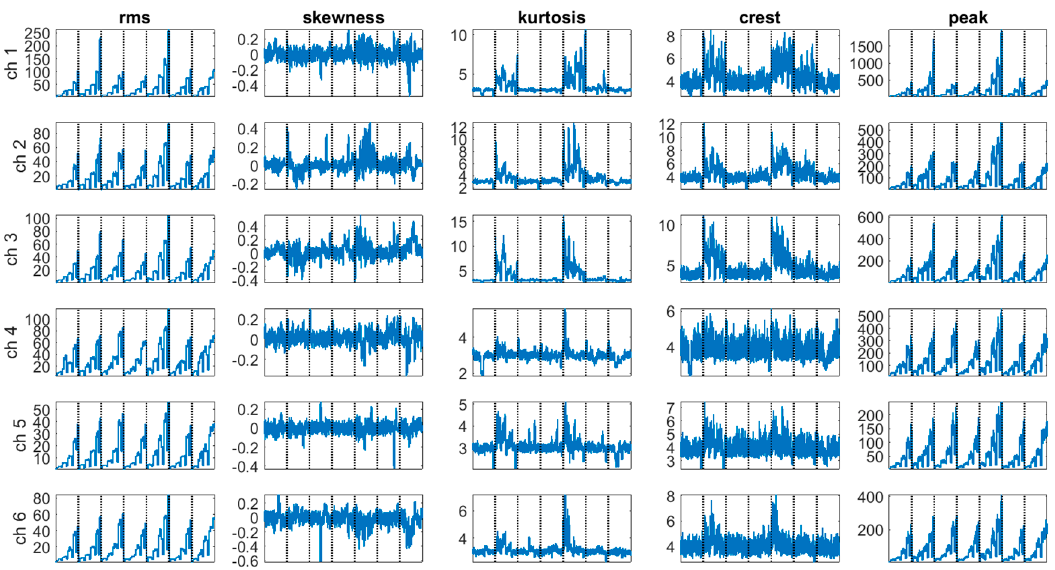
Figure 2. The considered dataset after features extraction. The black dotted lines divide the different damage conditions (0A to 6A). For each, the 100 observations for the 17 speed and loads conditions are plotted sequentially.